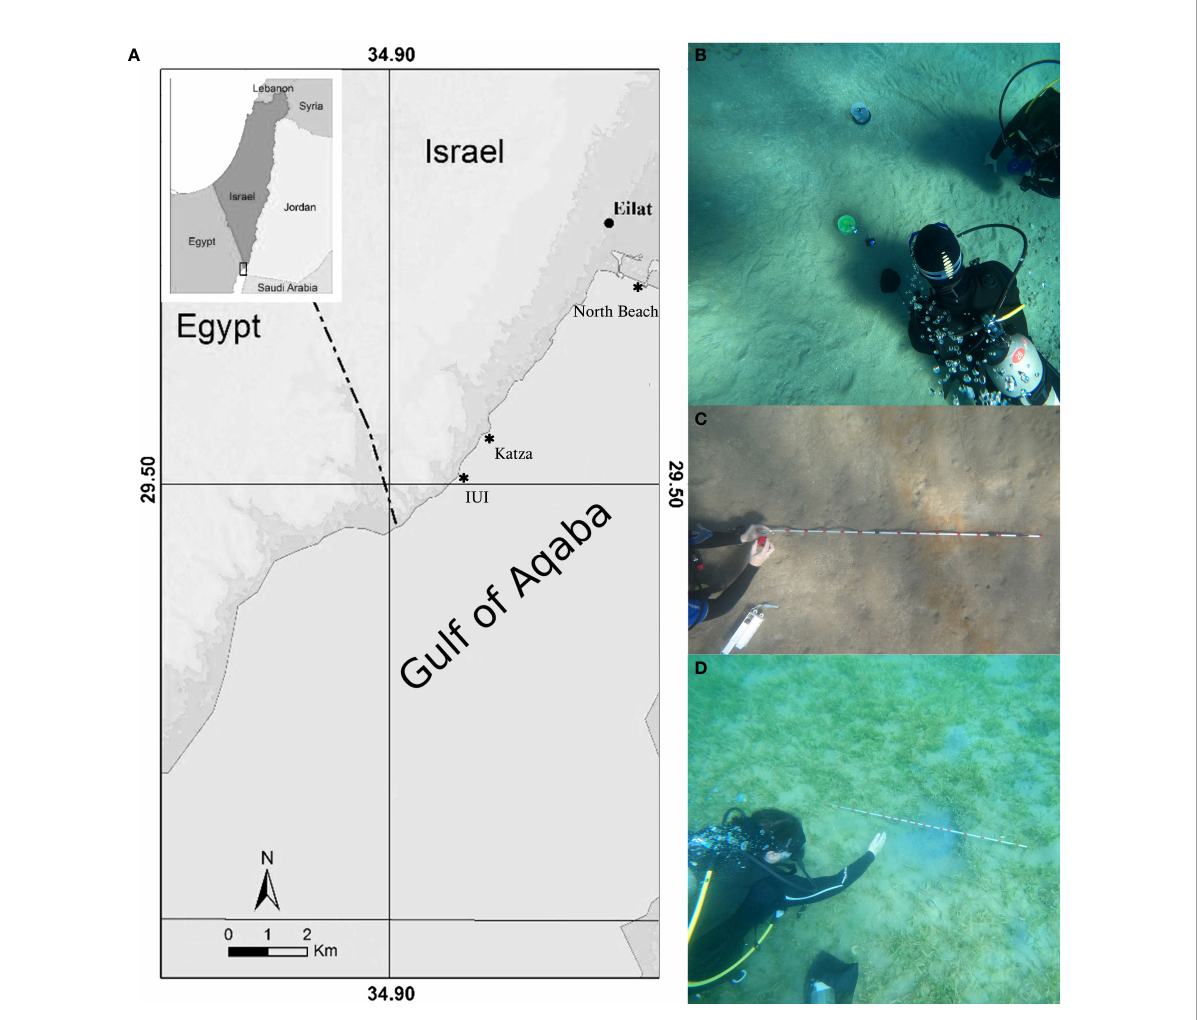
FIGURE 1 (A) Map of the study area with position of Israel and Red Sea relative to the surrounding countries (inset) (modi fi ed after Winters et al., 2017). The solid stars and the corresponding site names represent the localities where the in situ experiments were conducted. Photographs taken by the authors showing the environmental setting in (B) IUI, (C) Katza and (D) North